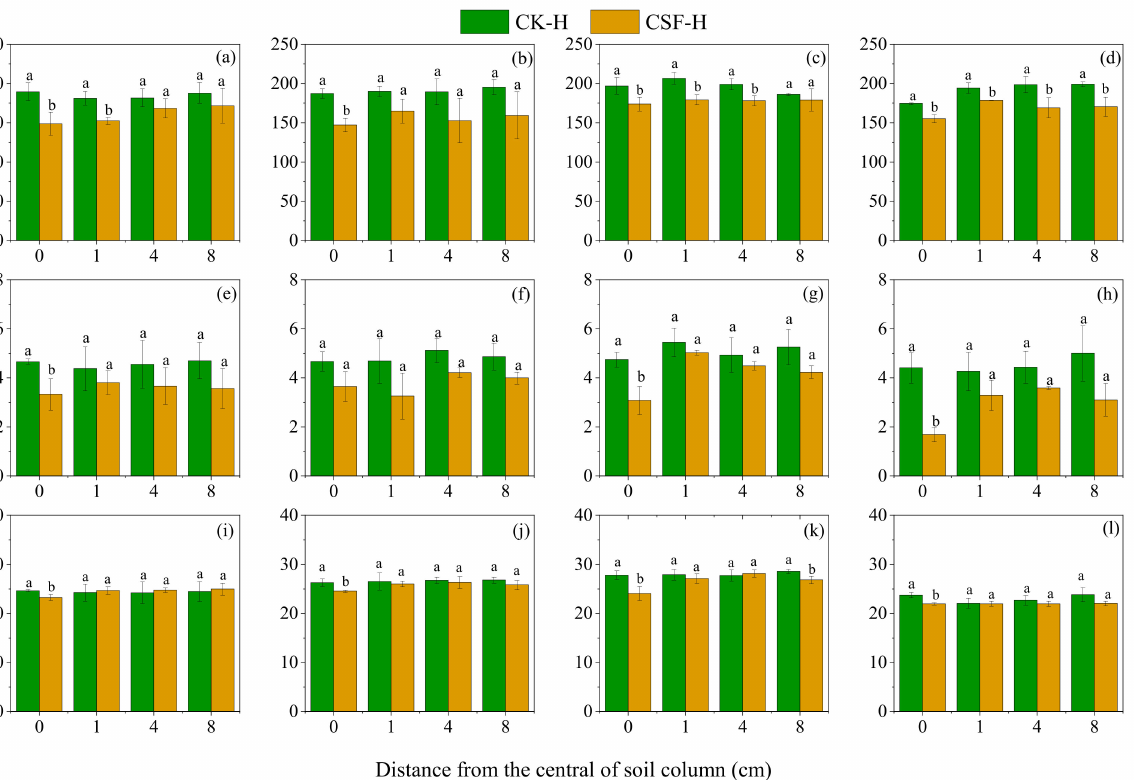
Figure 2. The effect of horizontal migration of CSF on the concentrations of bioavailable Cd, Pb, and As in the surrounding soil, the lowercase letters indicate a significant difference between CK and CSF treatments for the same distance. ( a , e , i ): Day 15 of incubation; ( b , f , j ): Day 30 of incubation; ( c , g , k ): Day 60 of incubation; ( d , h , l ): Day 100 of